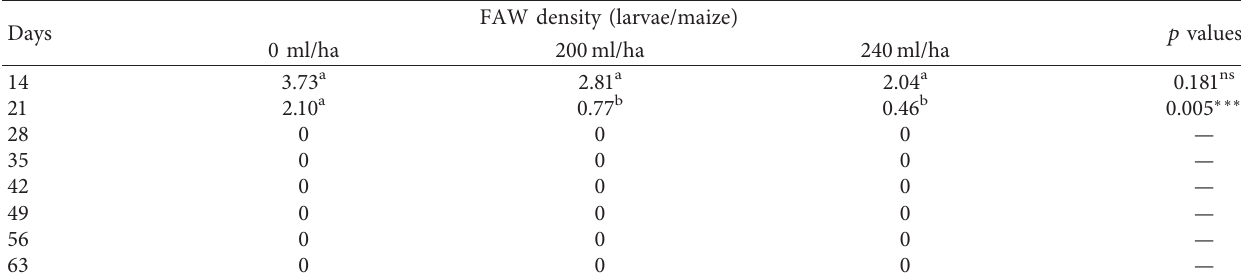
Table 3: Fall armyworm (FAW) density on maize leaf and whorl before and after Ampligo application.